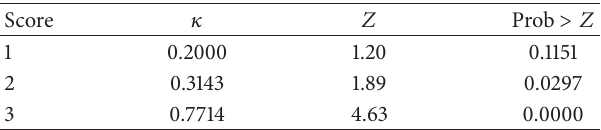
Table 3: Observer variability among 4 reviewers in malignant thy- roid